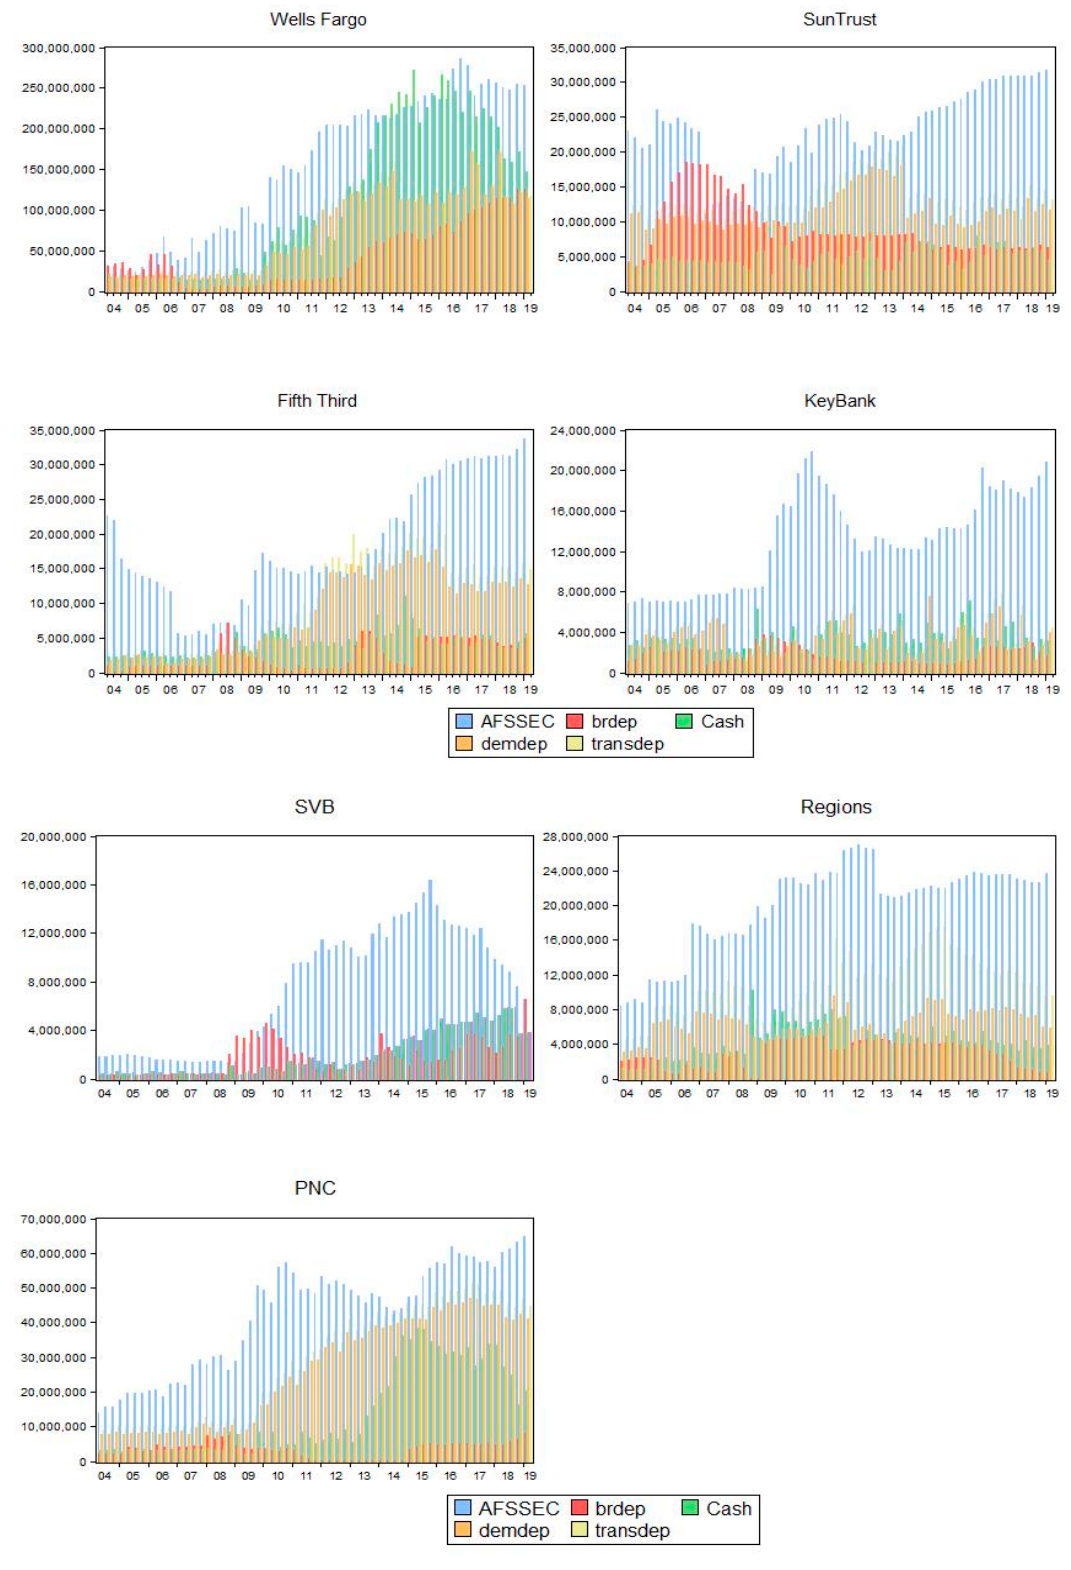
Figure A1. Balance-sheet variables. Source: Author’s computation.